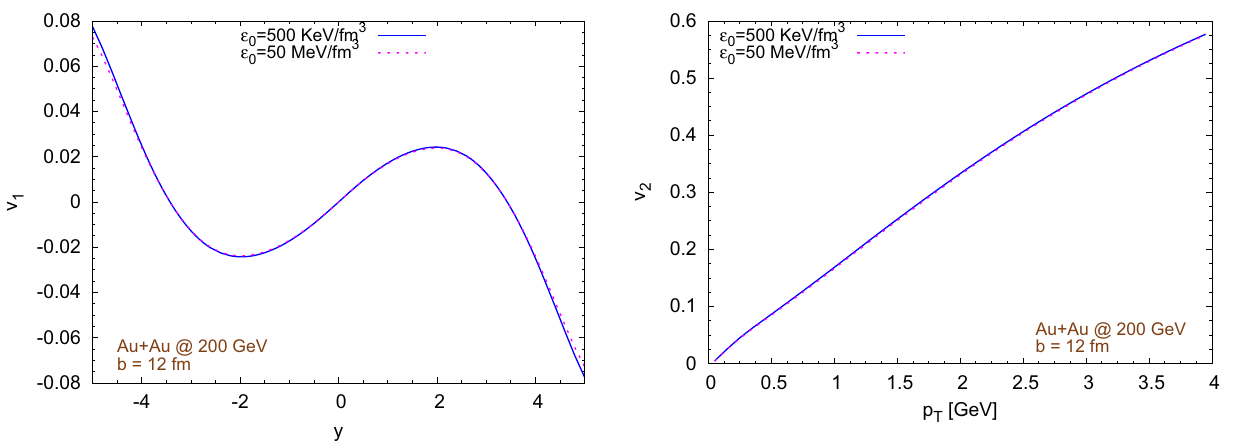
Fig. 16 Evaluation of the impact on the energy density pedestal intro- charged pions at mid-rapidity vs transverse momentum. We can notice how at RHIC energies the high energy density background has a very duced to stabilize the code on the Fourier harmonics v 1 , 2 . The figures √ s NN = 200GeV with an impact param- limited effect on v 2 at mid-rapidity, while we can notice some differ- refer to Au+Au collisions at eter b = 12fm and without magnetic fields. Left figure: integrated ences in v 1 for | y | > 4 directed flow of charged pions vs rapidity. Right figure: elliptic flow of